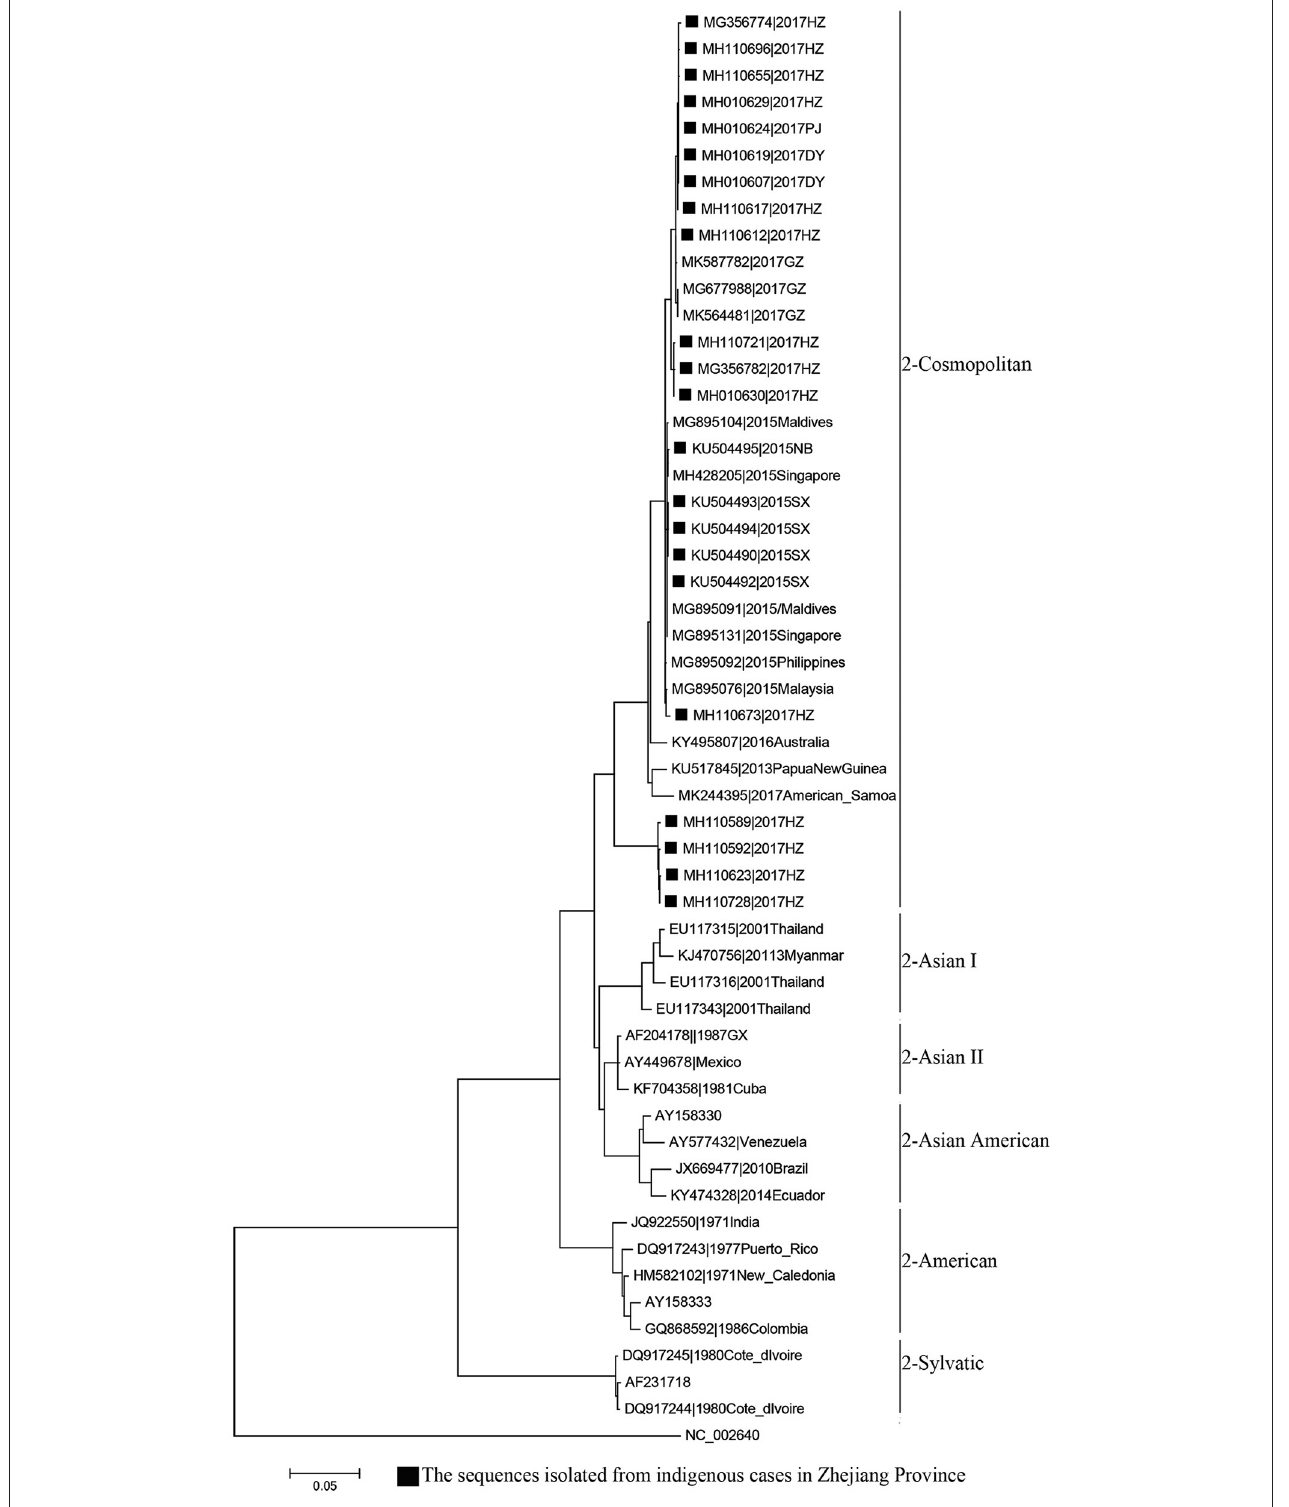
FIGURE 5 | Phylogenetic tree of DENV-2 strains based on the E gene.